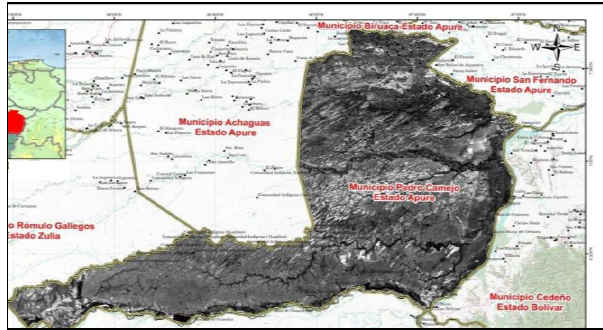
Figure 2. Image fraction of the vegetation component